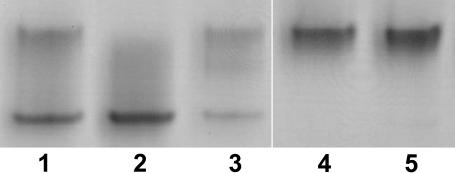
Nondenaturing PAGE Conformation Study of Recombinant Human TG2TG2 was incubated with effectors, then subjected to electrophoresis. Lane 1: TG2 incubated without effectors. As purified, this sample assumes two conformational states. Extended dialysis of purified TG2 leads to virtual disappearance of the faster-migrating species, suggesting that in the absence of both GTP and calcium, the protein adopts an open-like conformation. Lane 2: incubation of TG2 with GTP and MgCl2, allosteric inhibitors of the enzyme, increases the relative abundance of the conformation with higher electrophoretic mobility. Lane 3: incubation of TG2 with CaCl2, the enzyme activator, reduces the relative abundance of the higher mobility conformer. The lower overall intensity of this lane can be explained by oligomerization, as evidenced by multiple bands of lower electrophoretic mobility (unpublished data). Lane 4: active-site–inhibited TG2 incubated without effectors assumes a conformation with the lower electrophoretic mobility. Lane 5: incubation of active-site–inhibited TG2 with GTP and MgCl2 does not cause a shift in mobility as it does for uninhibited TG2.